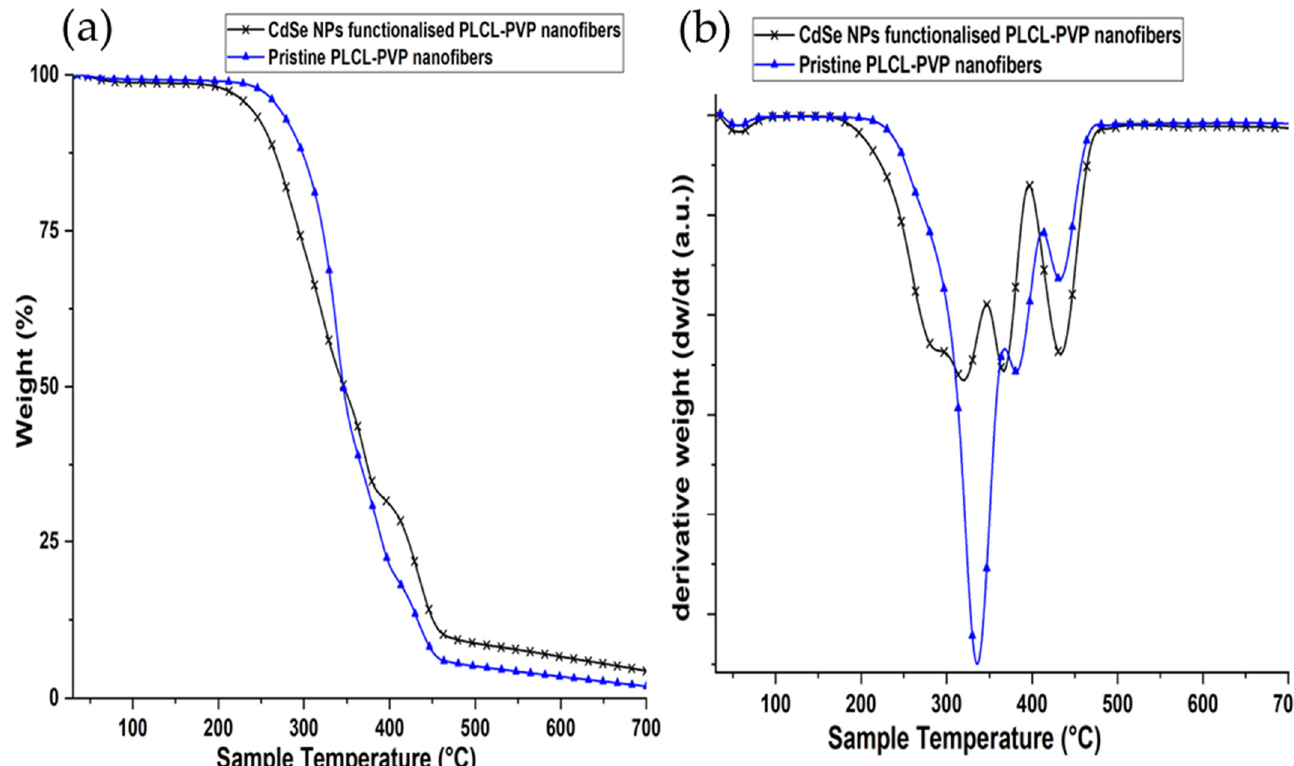
Figure 6. Thermogravimetric analysis ( a ) and derivative thermogravimetric analysis ( b ) of the pristine and QDs-immobilized PL-b-CL/PVP nano fi bers showing their mass degradation pro fi le and e ff ect of immobilization of CdSe QDs on thermal stability of nano fi bers.